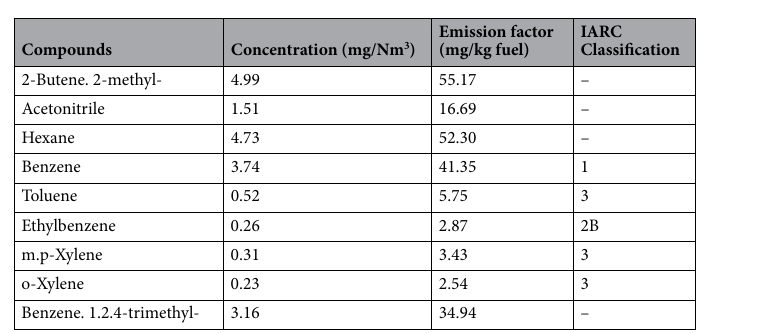
Table 8. Main VOCs identified in the emissions. Bold the BTEXs and their classification for IARC.